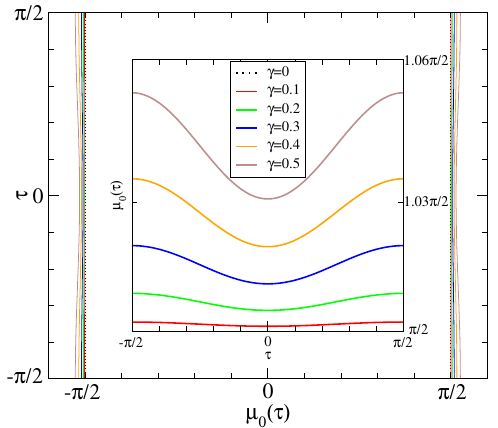
Figure 1 . Penrose diagram of the perturbed BTZ black hole depicted for various (cid:13) . The relevant solution involves the scalar perturbation (3.12) with m 2 =